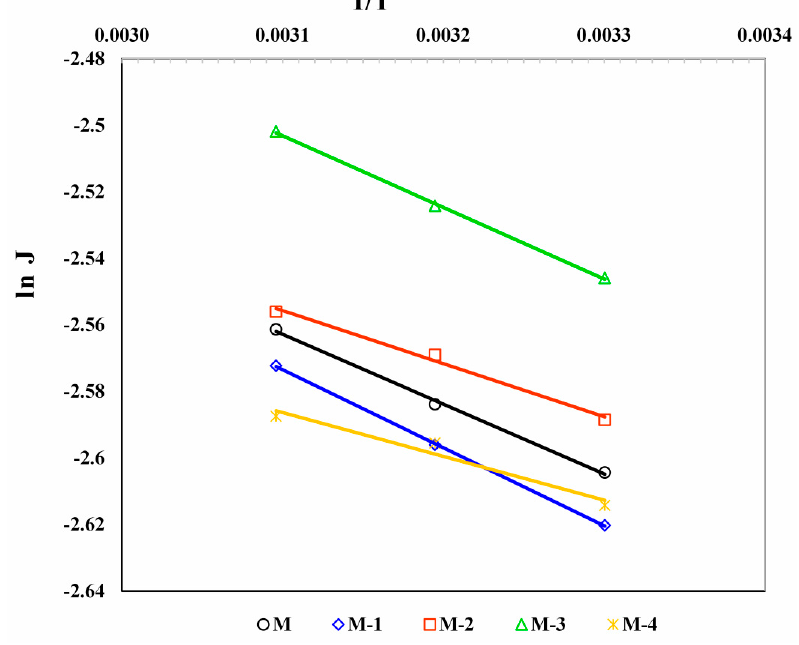
Figure 7. Effect of Ge content in NaCMC membranes on flux with temperature.